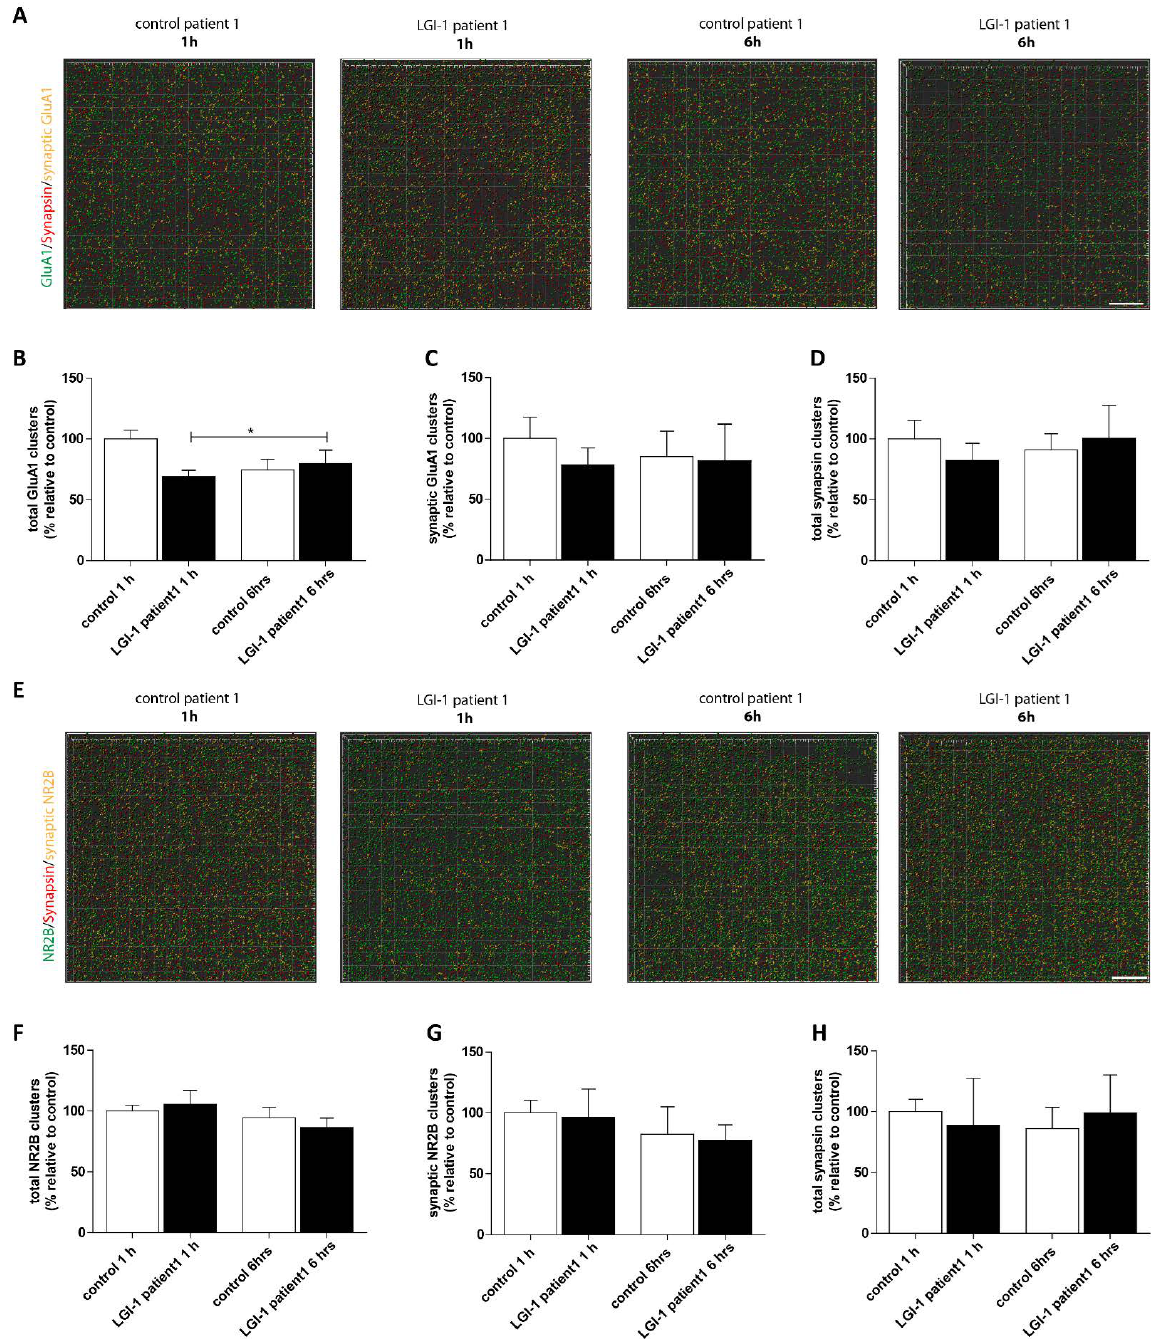
Figure 6. Cluster differentiation of NMDA-R and AMPA-R. Patient LE#1-derived LGI1 abs cause no alteration in synaptic AMPA-R or NMDA-R ratios. ( A , E ) A 3D projection of analyzed AMPA-R (upper panel) and NMDA-R (lower panel) clusters in second to third-order dendritic branches of area CA1 that were colocalized or non-colocalized with synapsin. Scale bar = 5 µ m. Quantification of the total ( B ) and synaptic ( C ) AMPA-R clusters, and synapsin clusters ( D ) in hippocampal acute slices treated for 1 or 6 h with patient-derived LGI1 or control abs after the LTP recording. Quantification of the total ( F ) and synaptic NMDA-R clusters ( G ), and synapsin clusters ( H ) in hippocampal acute slices of individual mice treated for 1 h or 6 h with patient-derived LGI1 or control abs after the LTP recording. The mean density in 1 h control ab treated slices was defined as 100%. Data are represented as the mean ± SEM and analyzed by one-way ANOVA followed by Turkeys post-hoc test stating * p <